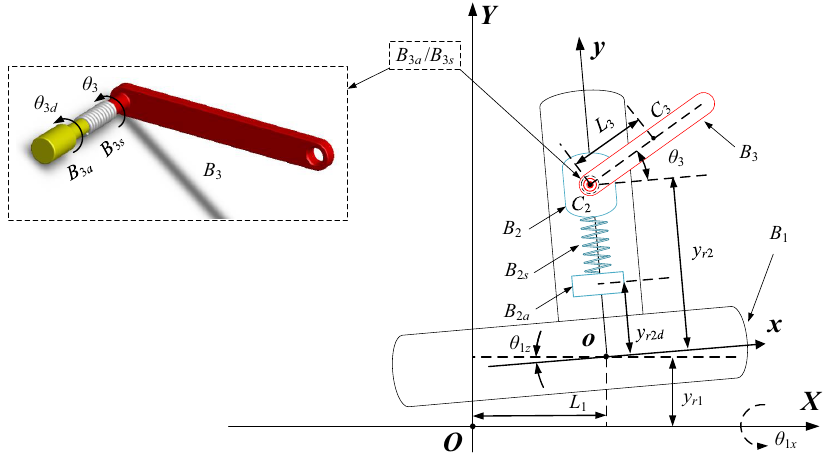
Figure 3. Simplified model of the ammunition transfer manipulator with base oscillations. Table 1. The meanings of the symbols. Symbols Meanings